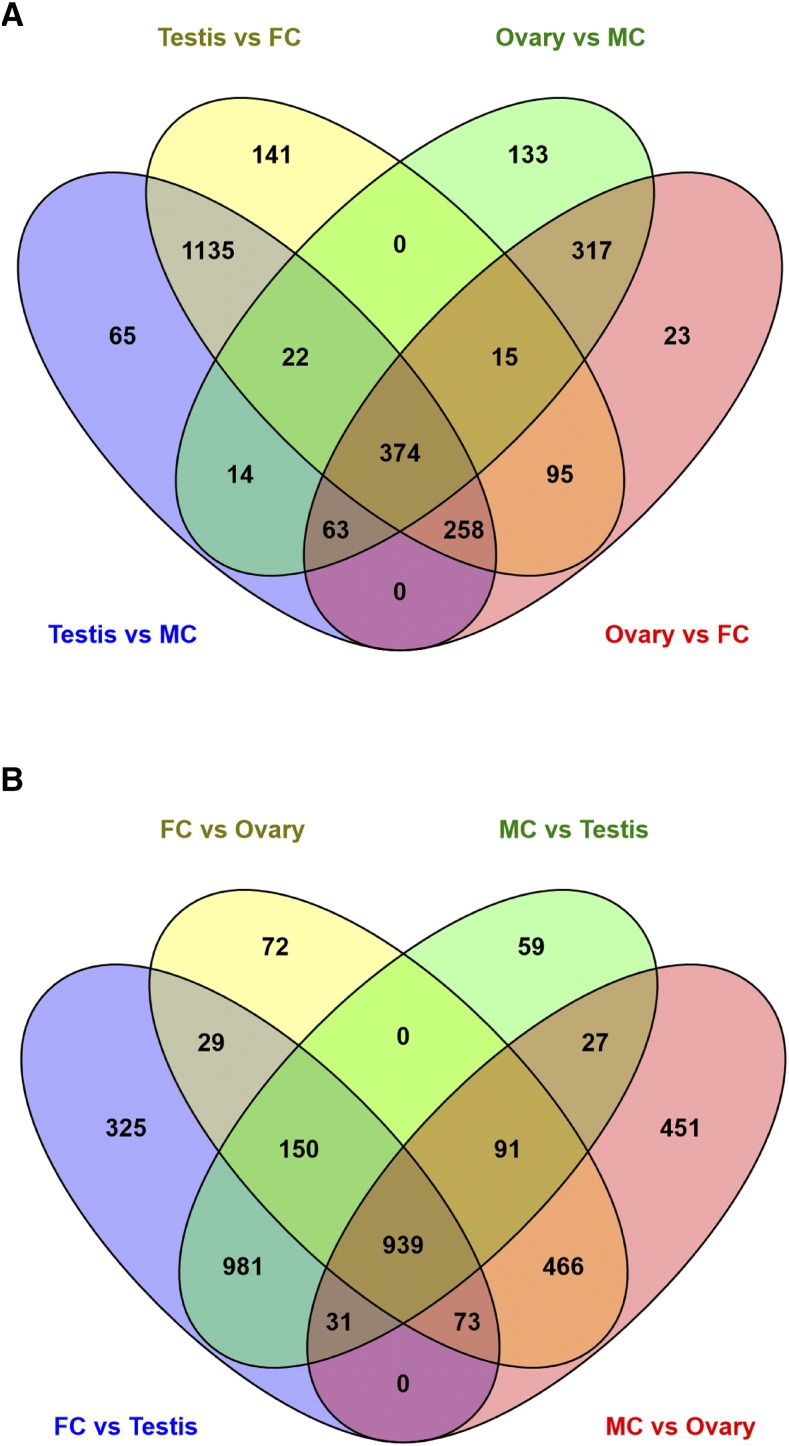
Differential gene expression in the Tribolium germ-line. List of genes with significantly increased expression in germ-line tissues. Genes in the common overlapping set show increased genes expression in germ-line such as in testis, ovary or both (A). Genes with significantly decreased expression in germ-line tissues as compared to the rest of the body (B).